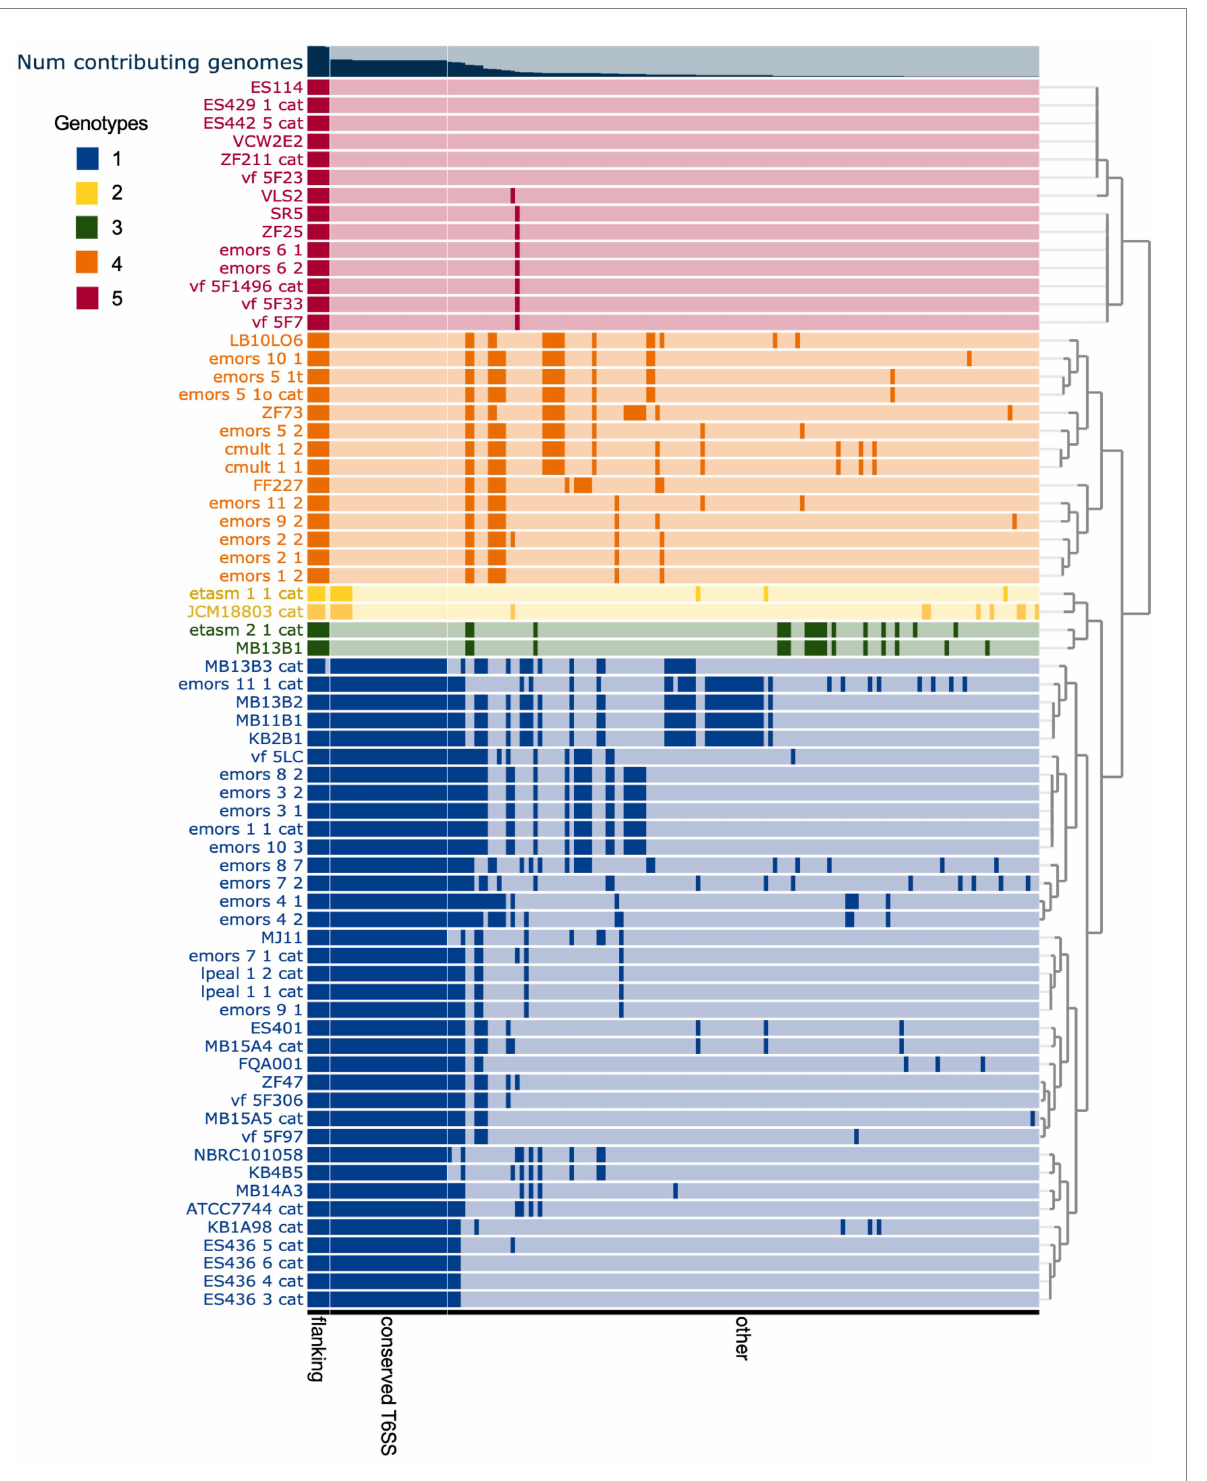
FIGURE 3 Comparison of predicted Vibrio fischeri T6SS2 genomic island regions reveals five distinct genotypes. Each row represents the T6SS2 genomic region of each V. fischeri strain based on presence of the manA and tRNA-Gly flanking genes. Gene clusters with shared similarity between strains are a darker shade of the row color. The strains are ordered based on hierarchical clustering of each T6SS2 genomic region, which revealed five distinct genotypes: (1, blue) a complete T6SS2 cluster and other genes, (2, yellow) an incomplete T6SS2 cluster and other genes, (3, green/ 4, orange) no T6SS2 cluster but several other genes, or (5, red) few to no genes in this region. Bar graph at top of chart indicates the percent of genomes that possess that gene cluster. Gene clusters are ordered based on binning of flanking genes (present in all genotypes), conserved T6SS genes (present in genotypes 1 and 2), and other non-T6SS genes which vary between the